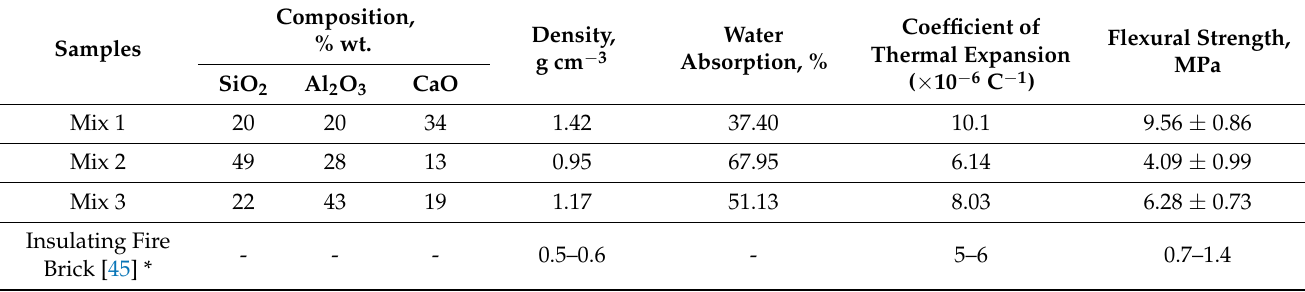
Table 8. Composition and properties of Ca-Al-Si-O-based insulating refractory materials. Data from [46].